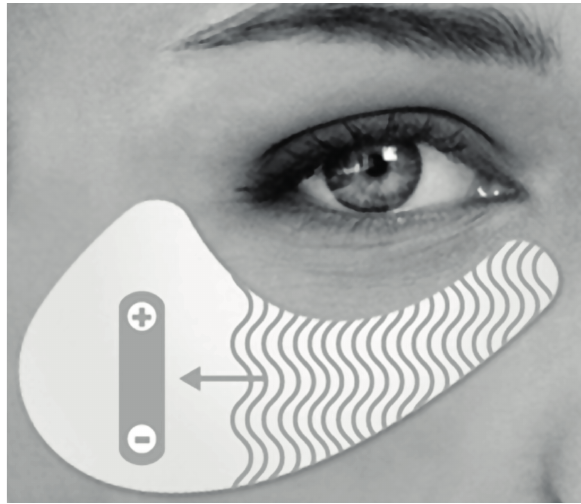
Figure 5 - Iontophoresis adhesive used adhered to the skin for cosmetic purposes Source: Modi fi ed from mapfremulher.com.br